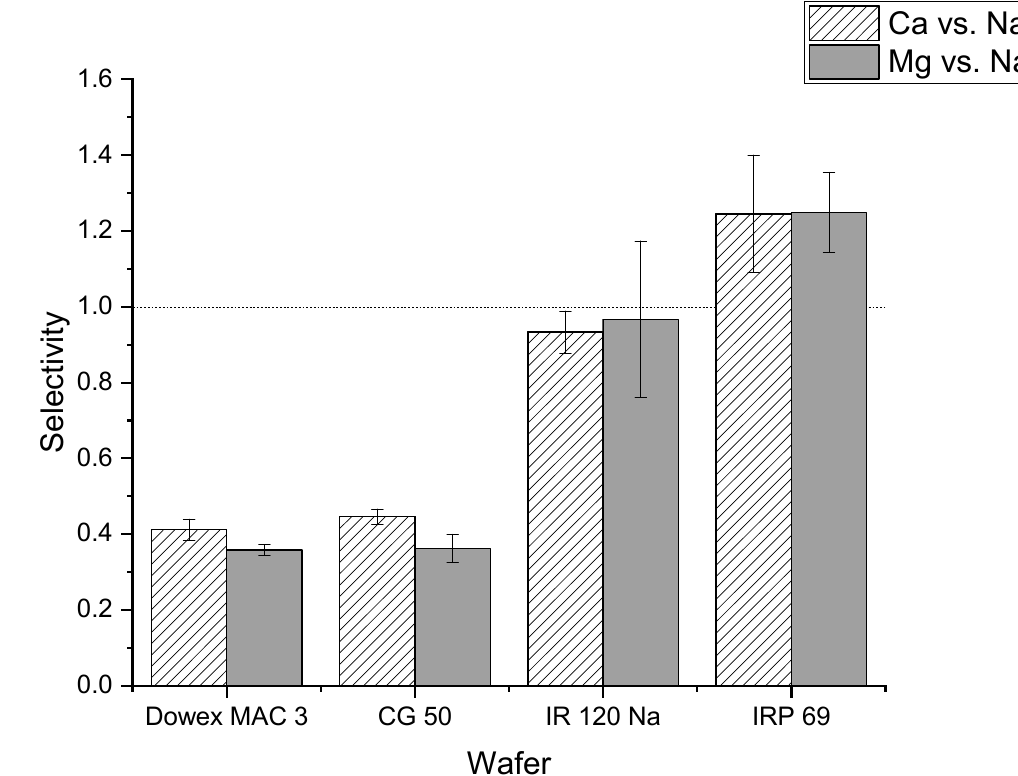
Figure 4. Comparison of selectivity values of calcium and magnesium relative to sodium for different strong cation exchange (IR 120 Na + and IRP 69) and weak cation exchange (Dowex MAC 3 H + and CG 50) resin wafers.